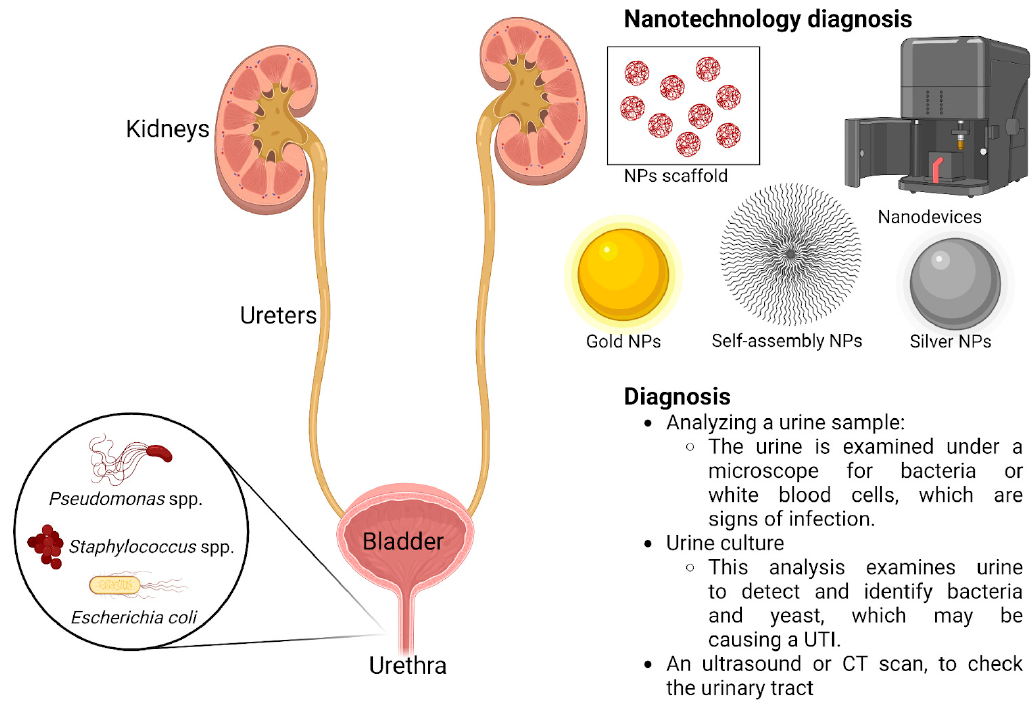
Figure 3. Diagnosis of urinary tract infections.